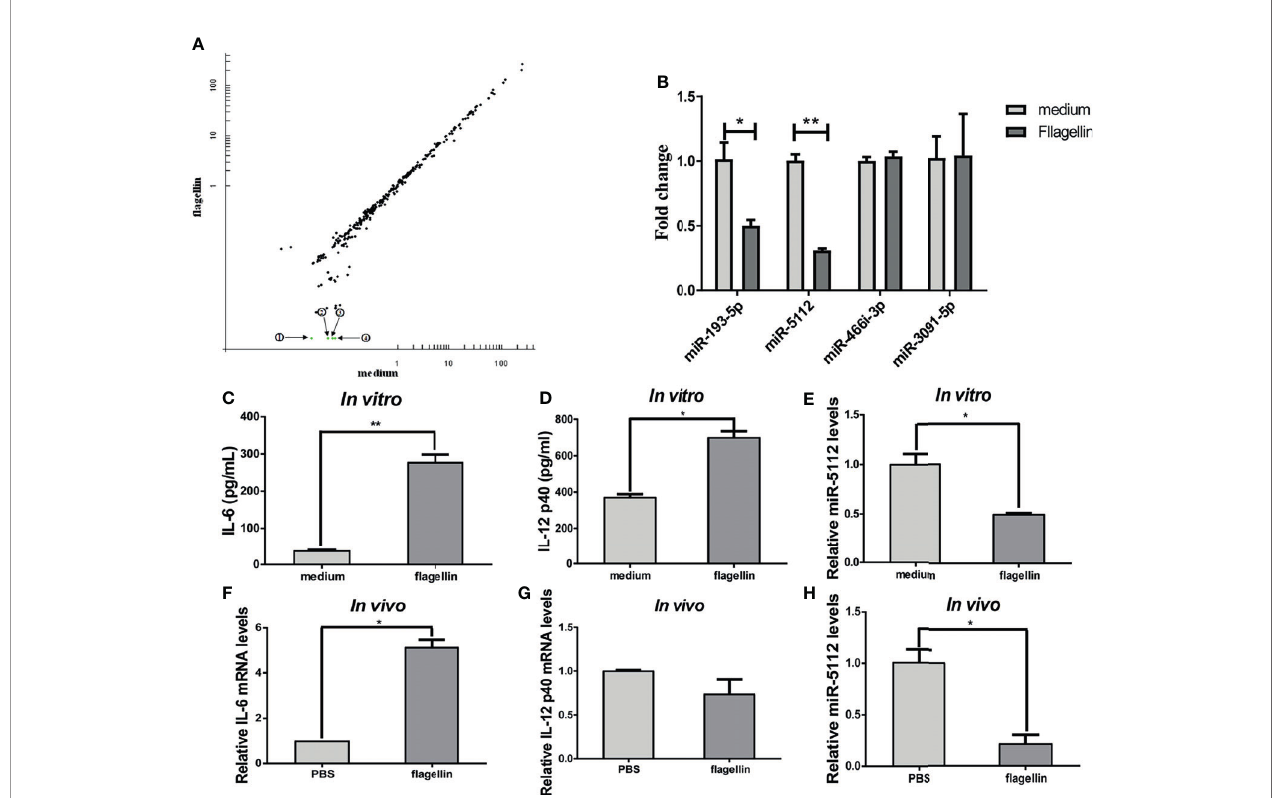
FIGURE 1 | miRNA expression analysis in fl agellin-activated DCs. (A) Microarray analysis of the miRNA expression pro fi le in BMDCs treated with fl agellin or with medium alone. The scatter plot shows the variation in miRNAs. Each plot represents one miRNA probe. The green dots represent a signal intensity ≤ 0.5 ratio between fl agellin-treated and medium-treated BMDCs, indicating signi fi cantly downregulated miRNAs. ① miR-193-5p, ② miR-5112, ③ miR-466i-3p, and ④ miR- 3091-5p. (B) Quantitative real-time PCR (qRT-PCR) to validate the miRNA expression pro fi le in fl agellin-treated BMDCs normalized to U6 small nuclear RNA levels. (C – E) Spleen DCs were isolated from three C3H/HeJ mice spleen using anti-CD11c-coated magnetic beads and stimulated with fl agellin (100 ng/ml) for 24 h. The IL-6 (C) and IL-12 p40 (D) production in culture supernatants was measured by ELISA. The expression of miR-5112 was measured by qRT-PCR (E) . (F – H) Spleen DCs were isolated from C3H/HeJ mice (n=3/group) immunized with fl agellin using anti-CD11c-coated magnetic beads, and the IL-6 (F) , IL-12 p40 (G) mRNA level and miR-5112 (H) was measured by qRT-PCR. The data shown represent the means ± SEM from 3 independent experiments. * P < 0.05, ** P <